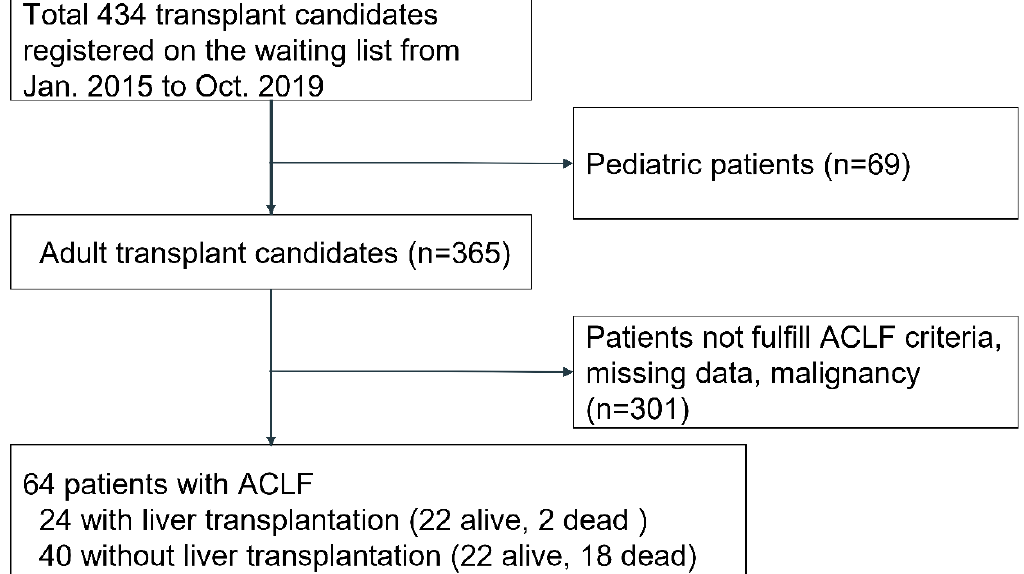
Figure 1. Schematic of the patient selection process.